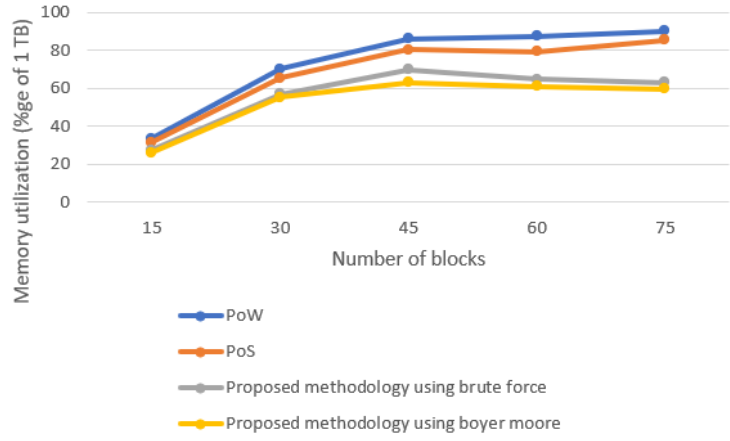
Figure 8. Memory utilization of different consensus approaches.